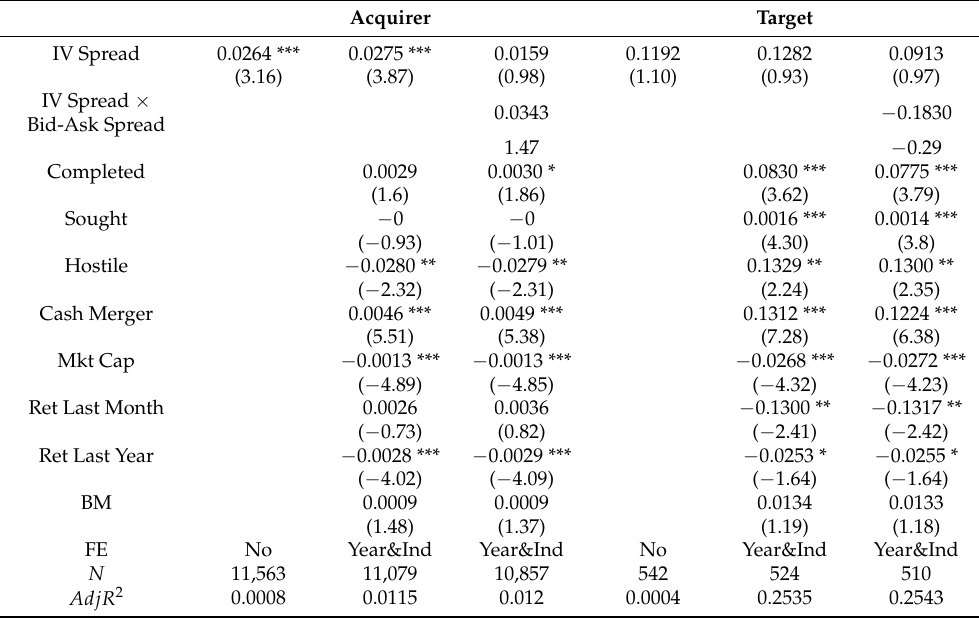
Table 6. Implied Volatility Spread and Merging Firm Announcement